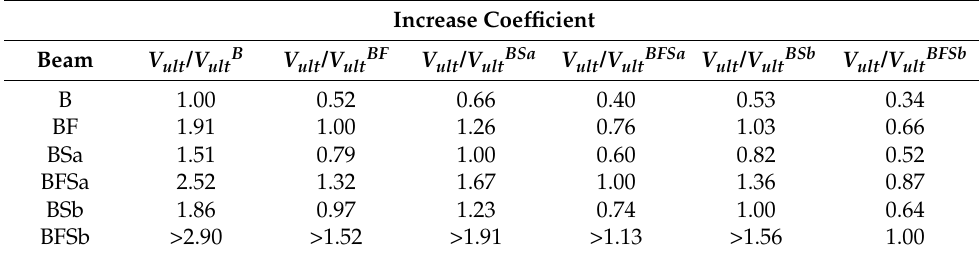
Table 5. Increase coefficients for particular beam